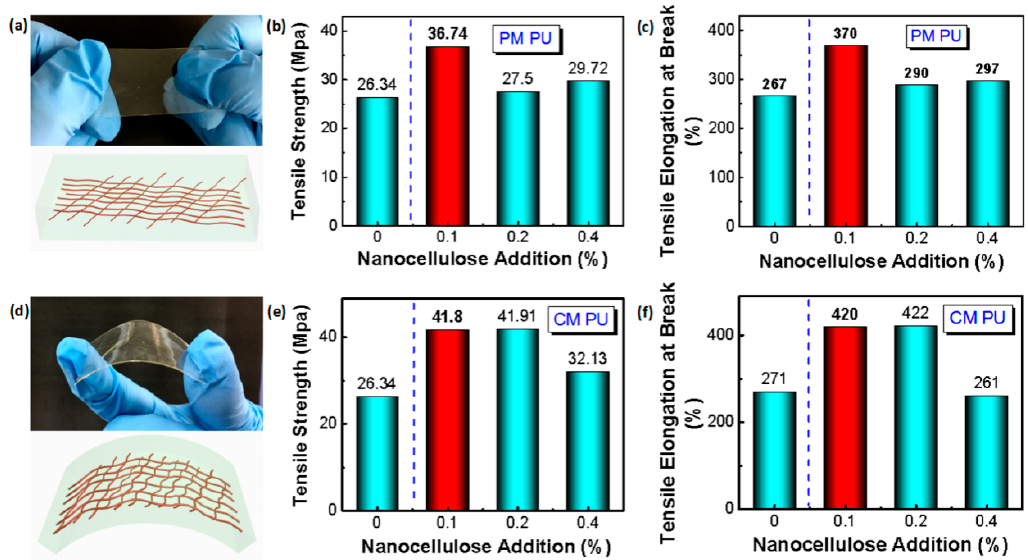
Figure 3. Comparison of tensile and fracture properties of the PU film. ( a ) Photograph and schematic of tensile state of the PU film physically modified by nanocellulose; ( b ) Comparison of tensile strength of physically modified PU (PM PU) with di ff erent amounts of nanocellulose addition; ( c ) Comparison of elongation at break of physically modified PU with di ff erent amounts of nanocellulose addition; ( d ) Photograph and schematic of the bending state of the PU film chemically modified by nanocellulose; ( e ) Comparison of tensile strength of chemically modified PU (CM PU) with di ff erent amounts of nanocellulose addition; ( f ) Comparison of elongation at break of chemically modified PU with di ff erent amounts of nanocellulose addition.